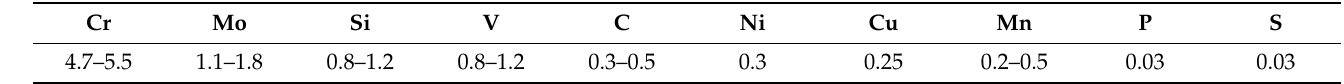
Table 1. The chemical composition of AISI H13 hot work tool steel (wt%). Cr